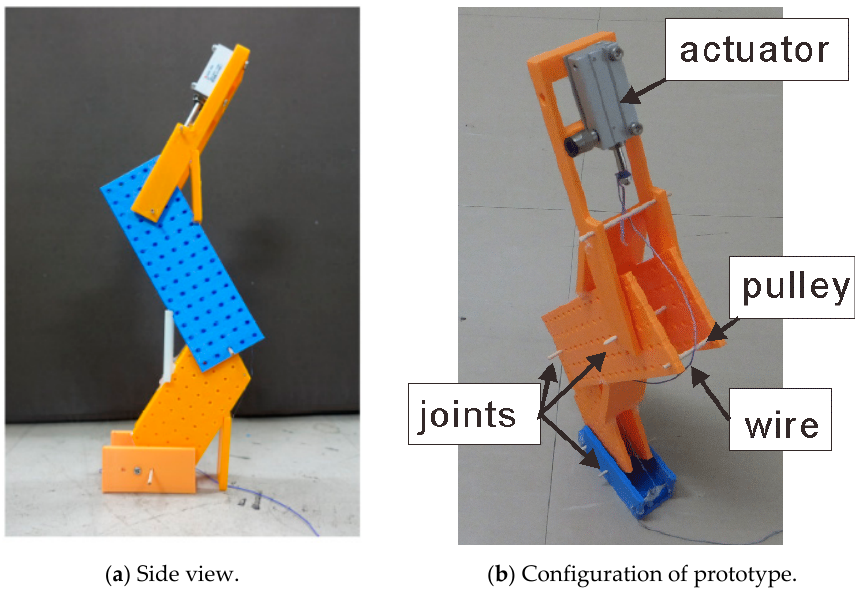
Figure 4. Developed three degree of freedom tendon ‐ driven robot. ( a ) Side view; ( b ) Configuration of prototype.